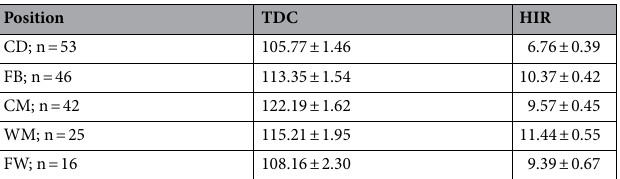
Table 1. The relation between running match performance and position of soccer players on the field in 20 UEFA Champions League matches (mean ± SE). TDC—total distance covered; HIR—distance covered in high- intensity running (speed > 19.8 km h −1 ).